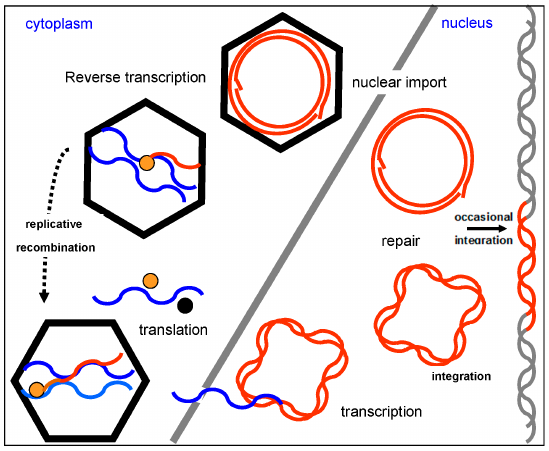
Figure 4. Replication cycle of plant pararetroviruses (Starting clockwise at 12 h): A virus particle containing open circular DNA has entered the cell. Its DNA is imported into the nucleus, where the gaps/overhangs are repaired to yield supercoiled dsDNA. Terminally redundant RNA is produced and transported into the cytoplasm. RNA copies are translated into virus proteins and/or packaged as two copies into virus particles. There reverse transcription occurs. The resulting open circular dsDNA reenters the replication cycle. In the lower left is shown how recombination can occur by template switching. On the right is shown how very rarely fragments of virus DNA incorporate into the plant genome, leading to endogenous viral sequences.